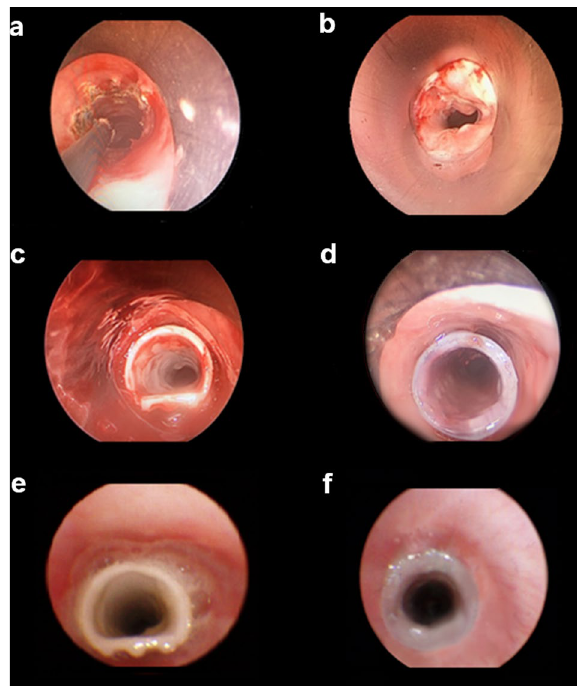
Figure 4. Evaluation of the performance of the GINA stent, compared to the Dumon stent, using porcine tracheal stenosis models. After inducing tracheal stenosis in 12-week-old pigs, a stent (GINA or Dumon) was inserted and the animals were observed for a time period 3 weeks. ( a ) The induction of stenosis (5 cm below the vocal cords) by means of cuff overpressure intubation and subsequent tracheal cautery. ( b ) Induced tracheal stenosis (a reduction in the measured airway cross-sectional area by at least 50%). ( c , d ) The GINA and Dumon stents inserted into the stenotic porcine tracheae. ( e , f ) The GINA and Dumon stents after 21